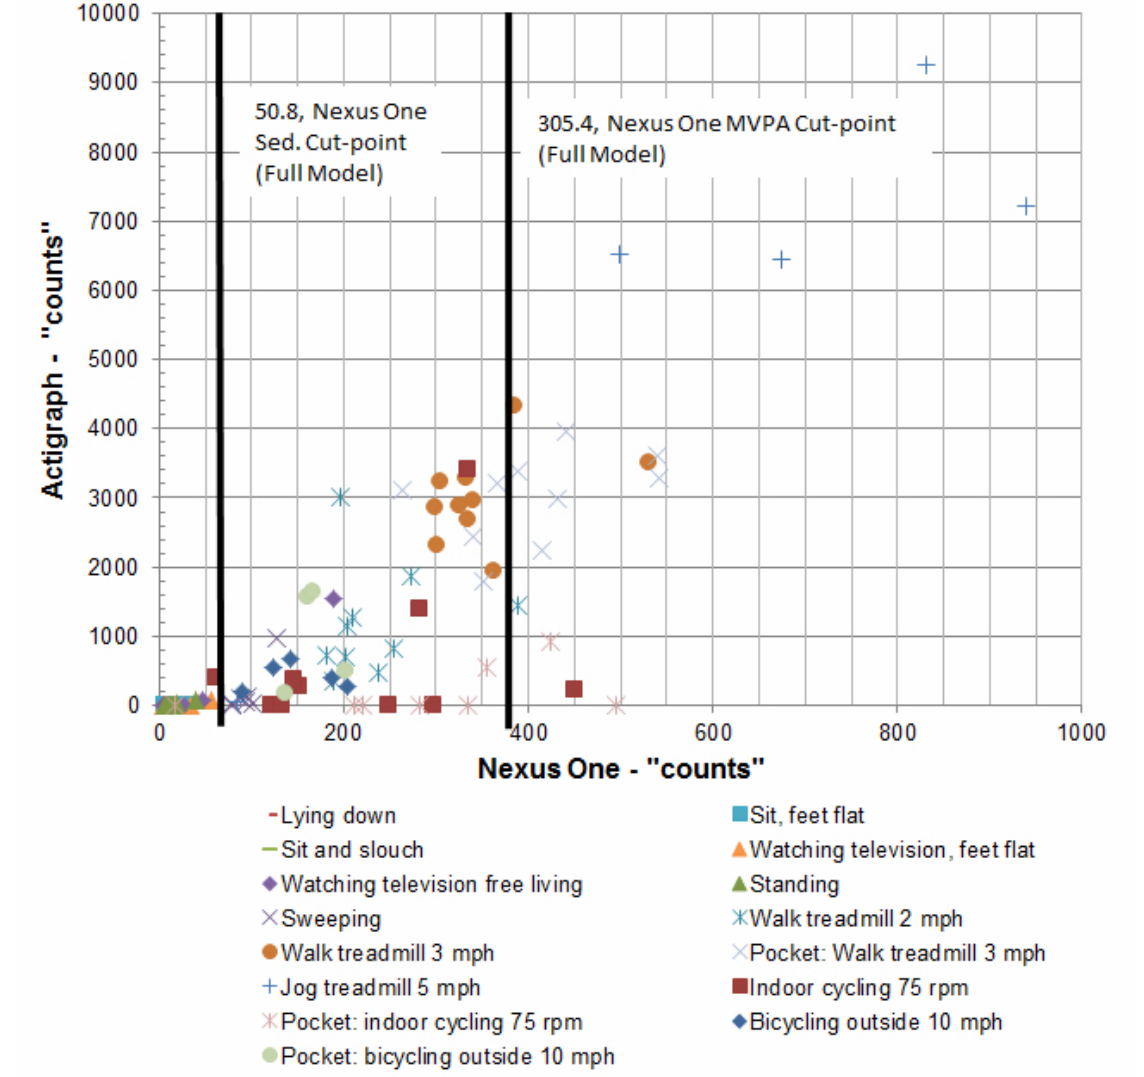
Figure 1. Phone to ActiGraph comparison across activities (laboratory